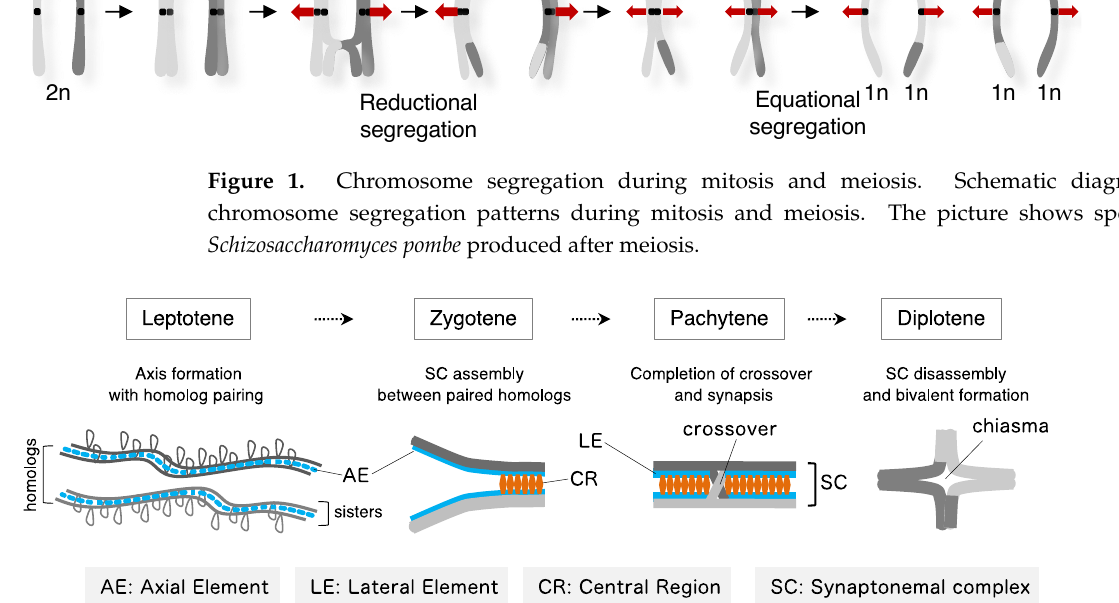
Figure 2. Chromosome organization during meiotic prophase. Schematic representation of chromosome organization during meiotic prophase in synaptonemal complex (SC)-forming organisms. Meiotic prophase is divided into four distinct stages: leptotene, zygotene, pachytene, and diplotene. The axial element (AE) is the precursor of the lateral element (LE) of the